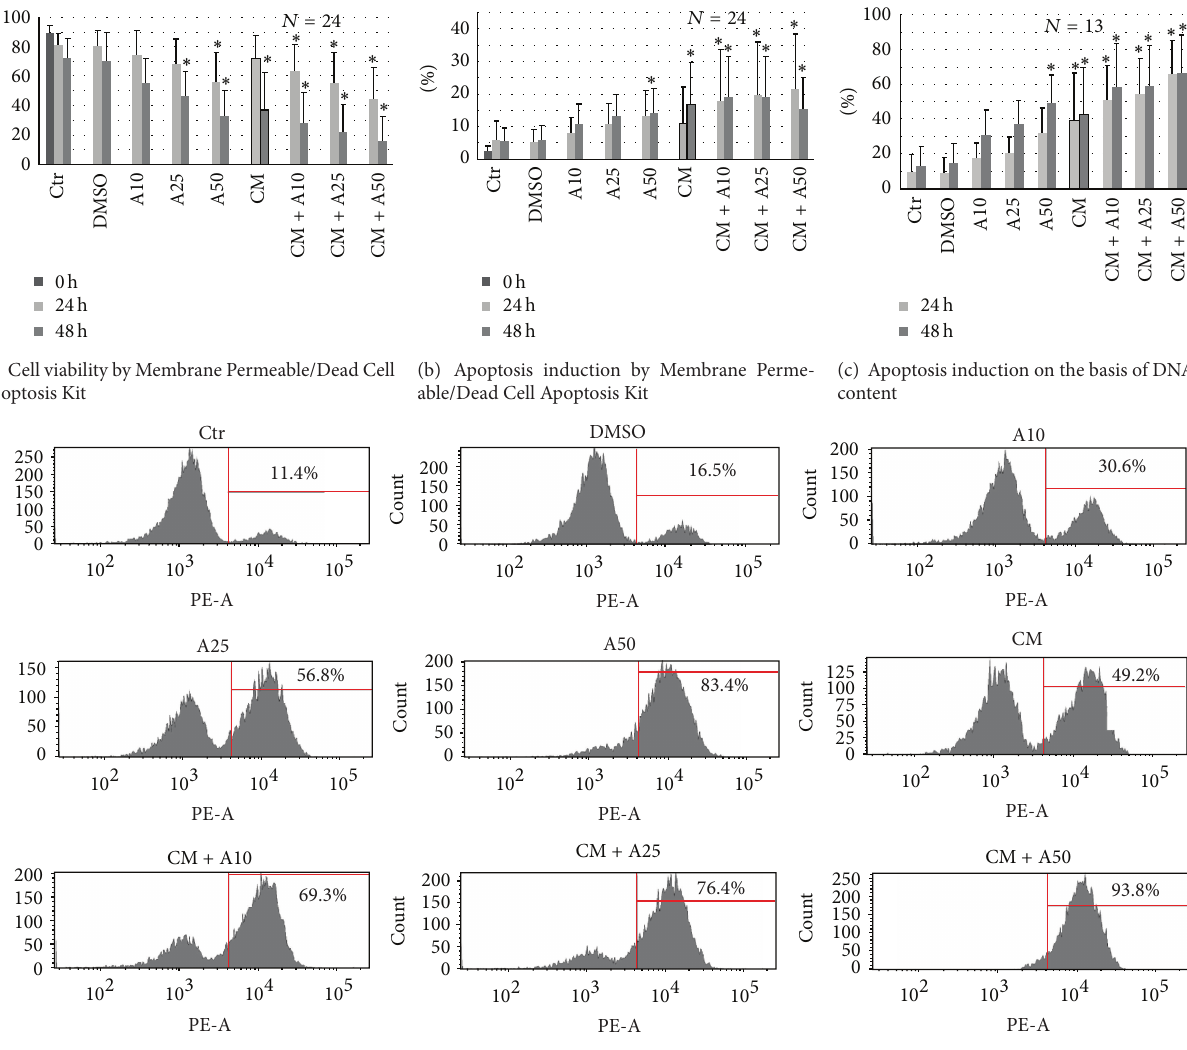
Figure 1: Antileukemic potential of atorvastatin (A), cladribine + mafosfamide combination (CM), or atorvastatin in combination with cladribine + mafosfamide (CM + A) evaluated on the basis of cell viability (a) and apoptosis induction (b–d) examination after 24 and 48 h CLL cell exposure. Proapoptotic activity of the tested drugs was evaluated by Permeable/Dead Cell Apoptosis Kit (b), DNA content analysis (c), and PE active caspase-3 apoptosis kit (d). ∗ the results were statistically significant at 𝑝 ≤ 0.05 .